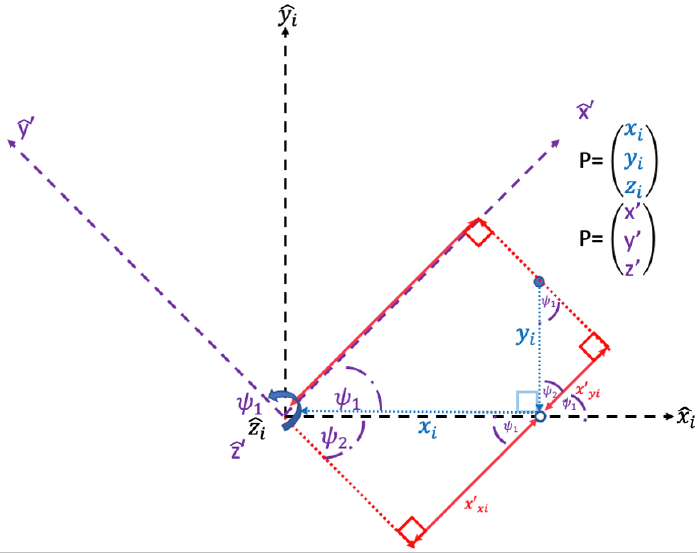
Figure 10. 3-rotation about the 𝑧 𝑖 ̂ and 𝑧′̂ axes, and identifying angles 𝜓 1 and 𝜓 2 and pertinent corresponding angles.